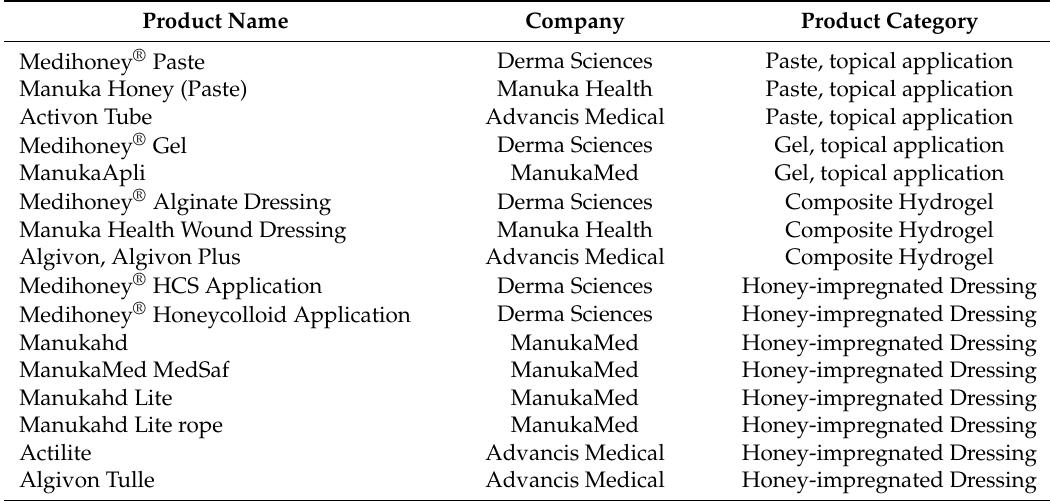
Table 2. Summary of commercial wound-care products containing Manuka honey currently on the